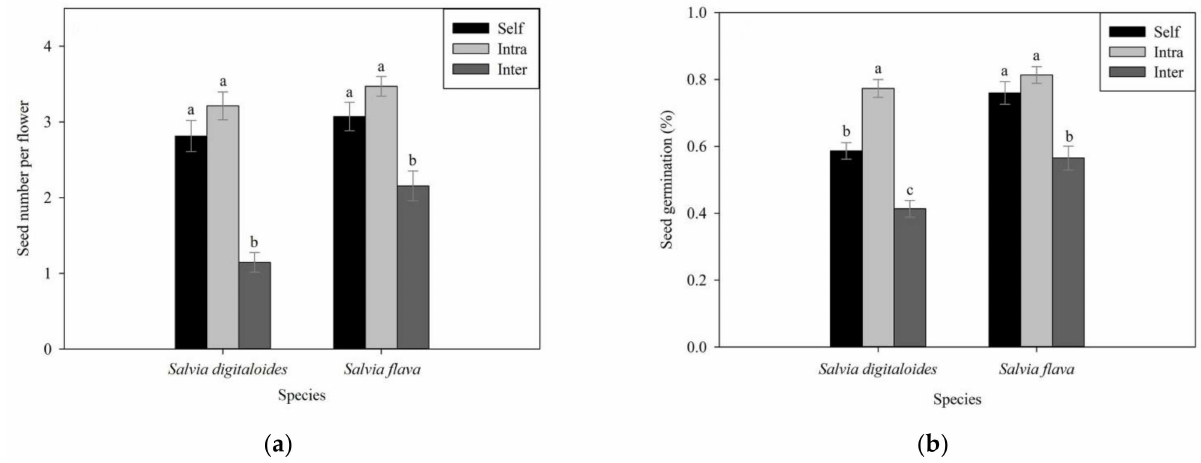
Figure 5. ( a ) Seed production and ( b ) germination of hand self- (black bars), intra- (light gray bars), and interspecific (dark gray bars) pollinations for Salvia digitaloides and S . flava . Different letters indicate significant differences at p < 0.05. Error bars represent mean ± standard errors.